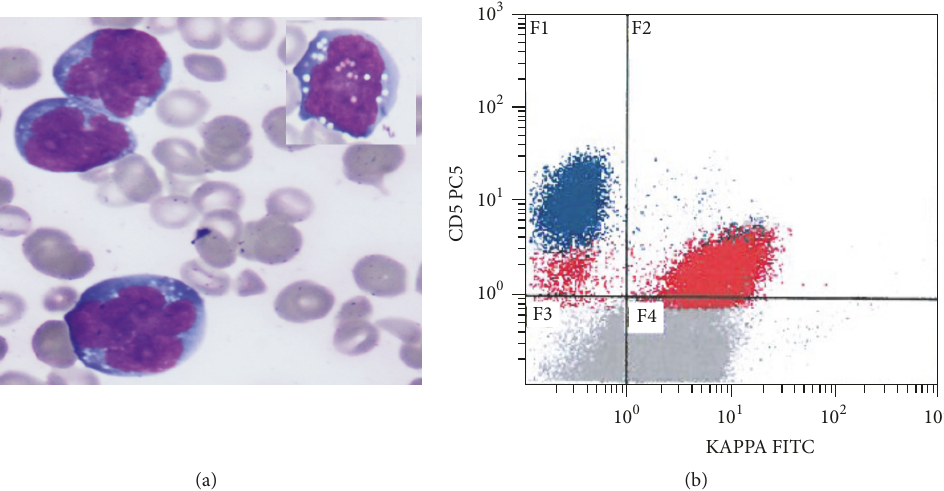
Figure 7: Peripheral smear at time of second relapse: Neoplastic cells show more pronounced nuclear irregularities with variable cytoplasmic vacuolation (a). Wright stain, 1,000x magnification. Flow cytometry on peripheral blood showed malignant cells with CD5 acquisition